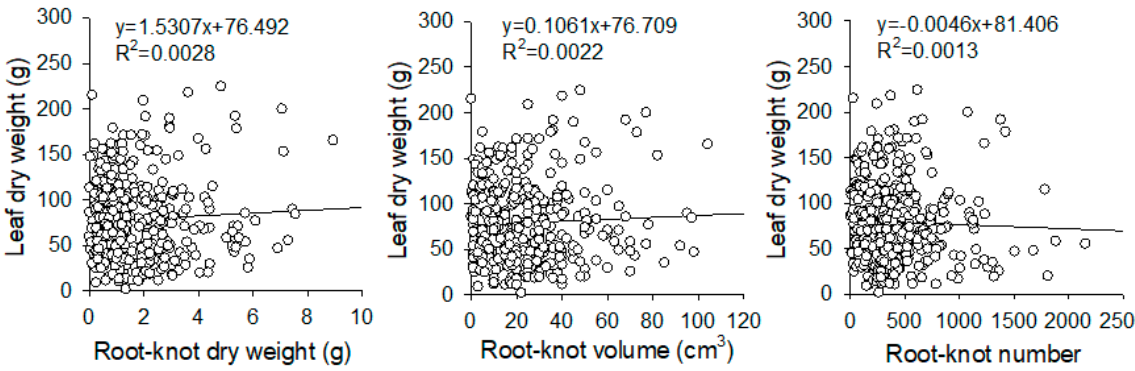
Figure 1. Regression between the leaf dry weight and the traditional indicators of disease degree and gall index. n = 360.